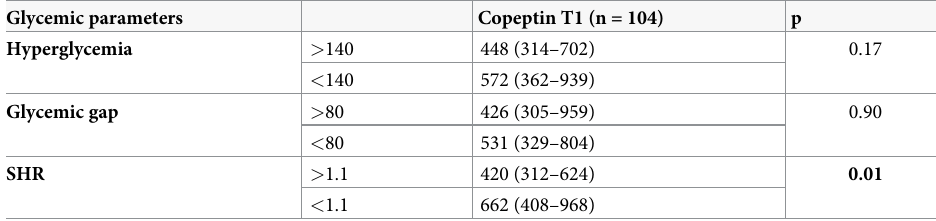
Table 2. Association of copeptin levels with glycemic